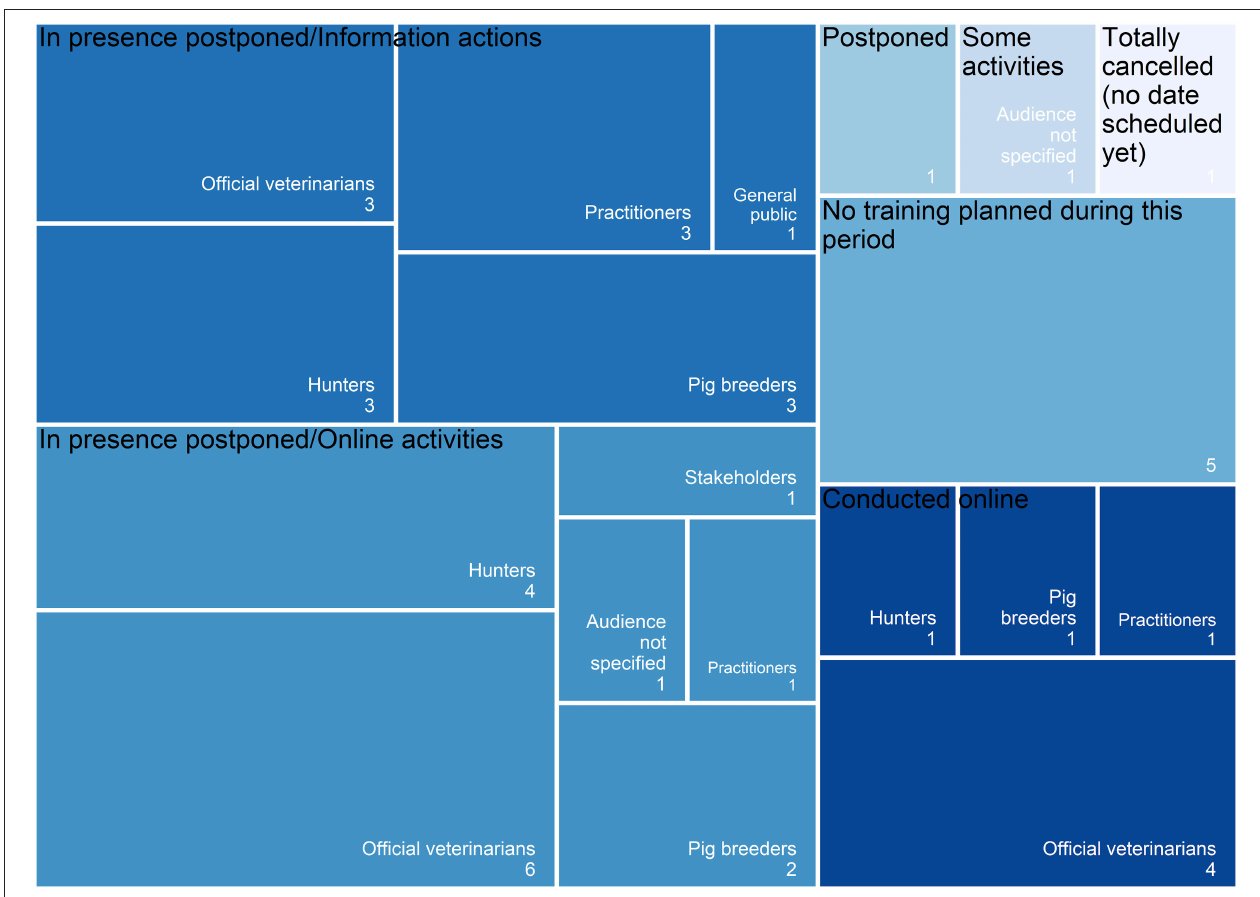
FIGURE 5 | Tree map visualization of the training activities on African swine fever and targeted audience of the online activities over the period March-May 2020, as reported by the 27 respondents from 24 countries. Size of the squares is proportional to the number of answers (indicated in the bottom right corner).